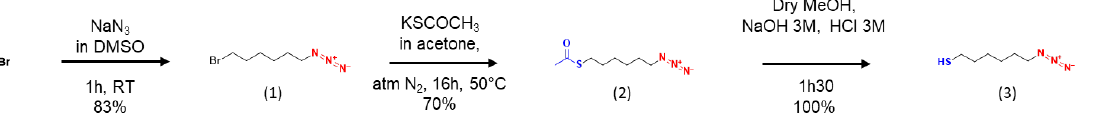
Figure A1. Synthesis of the 1-azido-6-thiohexane.